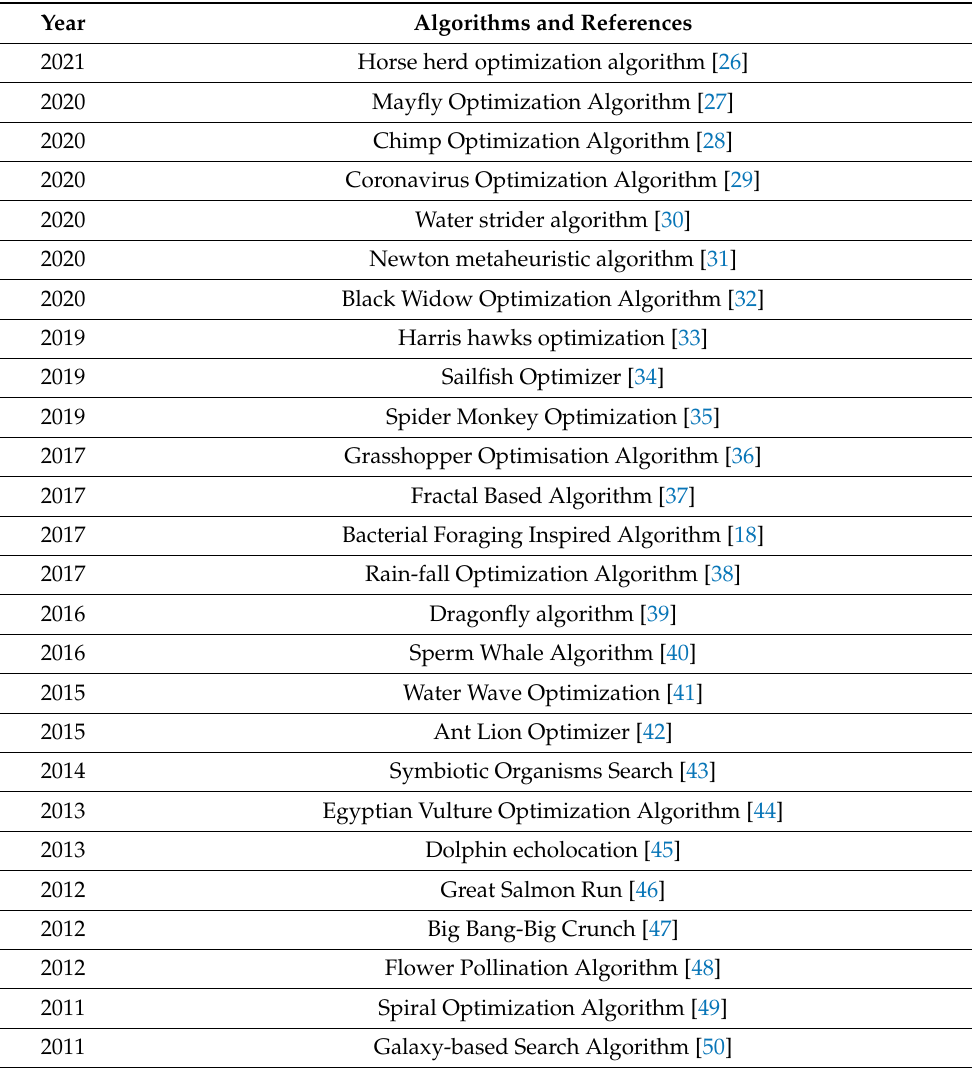
Table 1. Popular bio-inspired optimization algorithms based on swarm intelligence, physics, popula- tion, chemistry, and evolution.